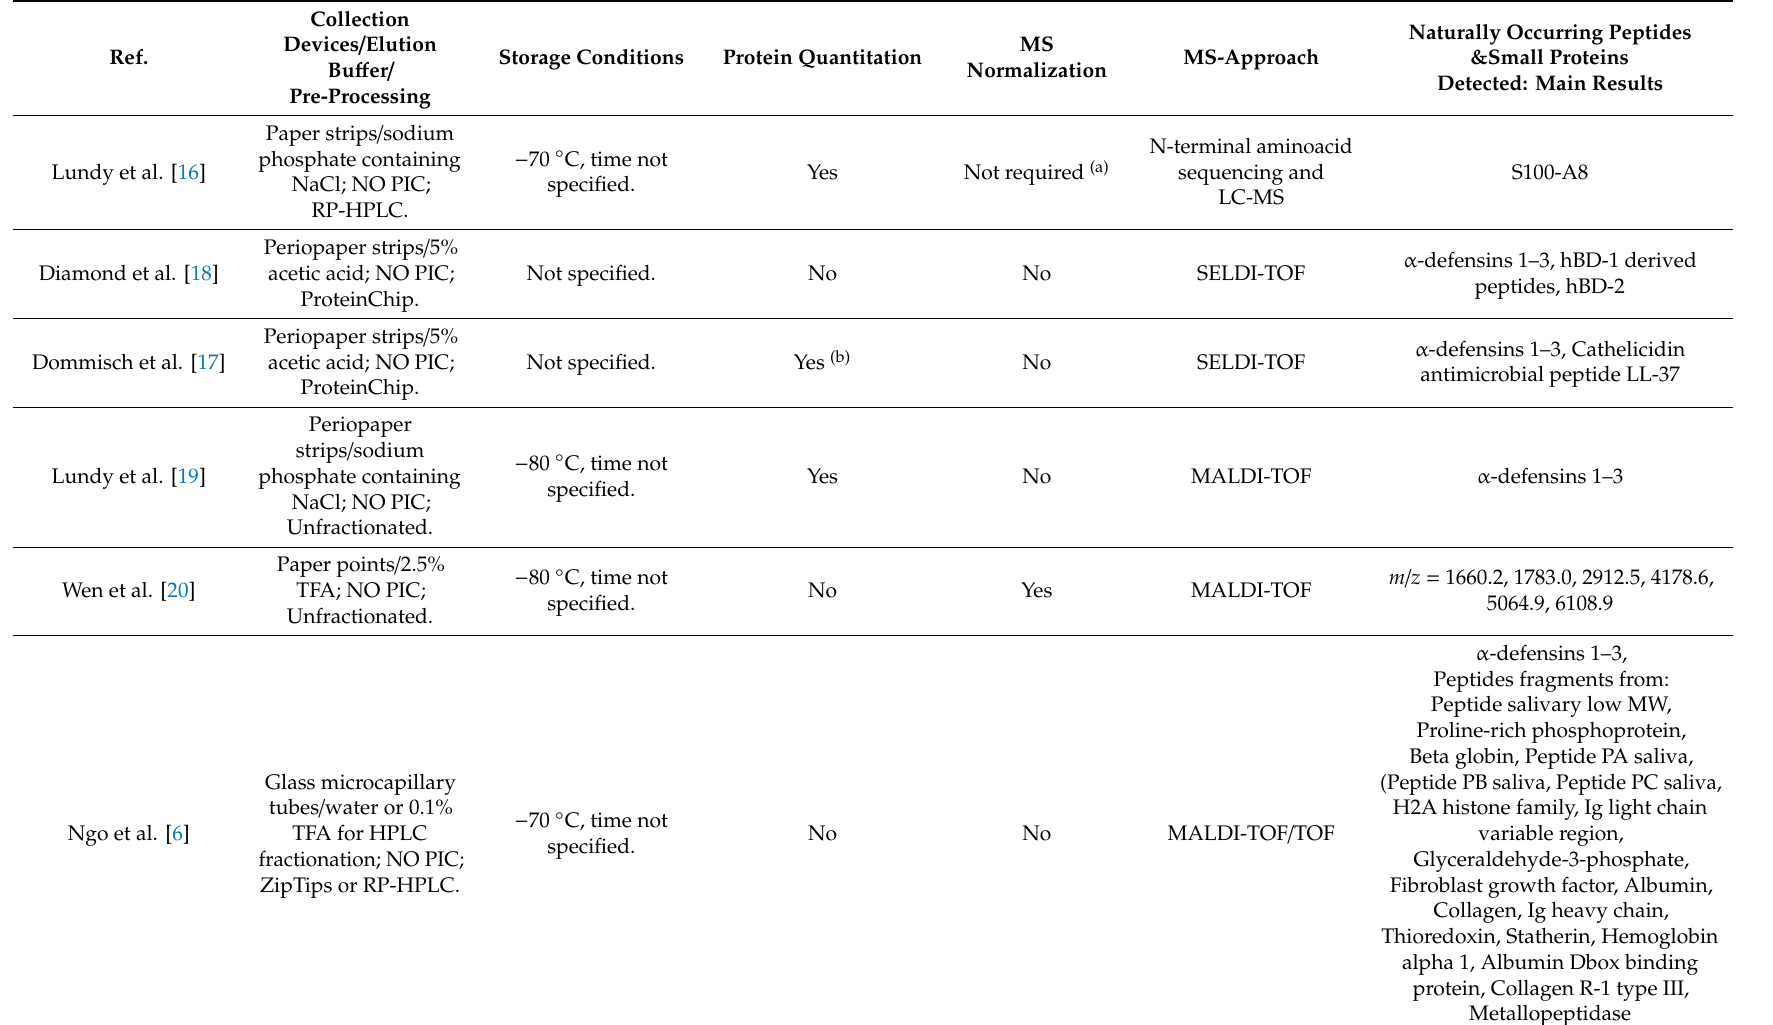
Table 1. Gingival crevicular fluid (GCF) peptidomics profiling